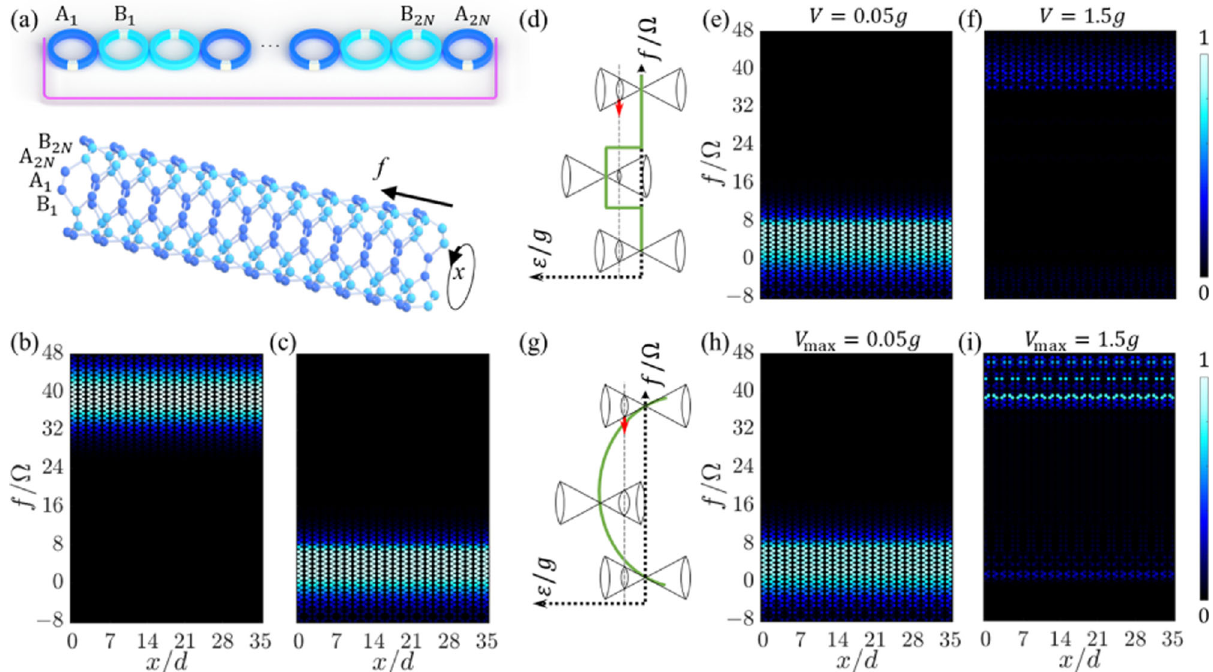
Fig. 2 Klein tunneling. a An external waveguide connects the fi rst (A 1 ) and last (A 2 N ) ring resonator together, which forms an effective carbon-nanotube- like honeycomb lattice in the synthetic space with spatial direction ( x ) being periodic and frequency dimension ( f ) being fi nite. N is the number of groups of rings. b The intensity distribution in the synthetic lattice of the initial plane-wave excitation at propagation time t = 0. Ω is the free spectral range, and d denotes the horizontal distance between two sites with the same types in the synthetic lattice. c The intensity distribution in the synthetic lattice at t = 42 g − 1 with no barrier, with g being the effective hopping amplitude. d The cartoon of the excited wave packet in the Dirac cone moving towards the negative direction along square-shape potential barrier (green line) with the frequency detuning ε (dashed gray line). The corresponding intensity distribution in the synthetic lattice with the square-shape potential barrier in d at t = 42 g − 1 with maximum potential value e V = 0.05 g and f V = 1.5 g . g The cartoon of the excited wave packet in the Dirac cone moving towards the negative direction along parabola-shape potential barrier (green line) with the frequency detuning ε (dashed gray line). The corresponding intensity distribution in the synthetic lattice with the parabola-shape potential barrier in g at t = 42 g − 1 with maximum potential value h V max ¼ 0 : 05 g and i V max ¼ 1 : 5 g . The red arrows in d and g present the direction of